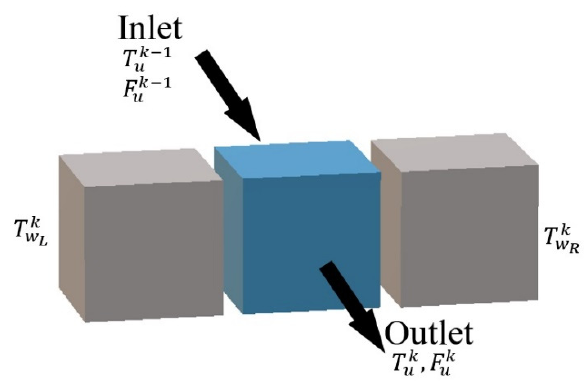
Figure 6. Representation of a cell k of utility plate.